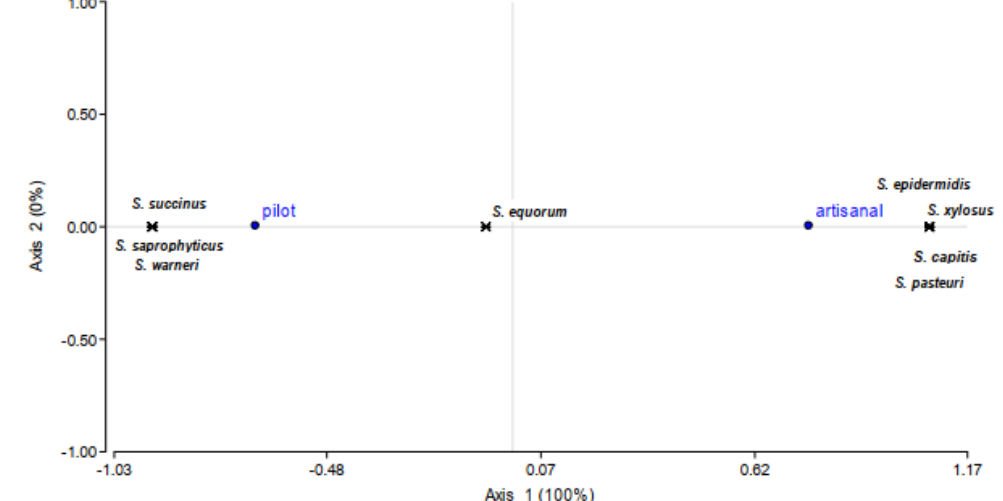
Figure 1. Correspondence analysis biplot of Staphylococcus ( S ) species and type of production (pilot or artisanal). Contribution to Chi-square is indicated in brackets.